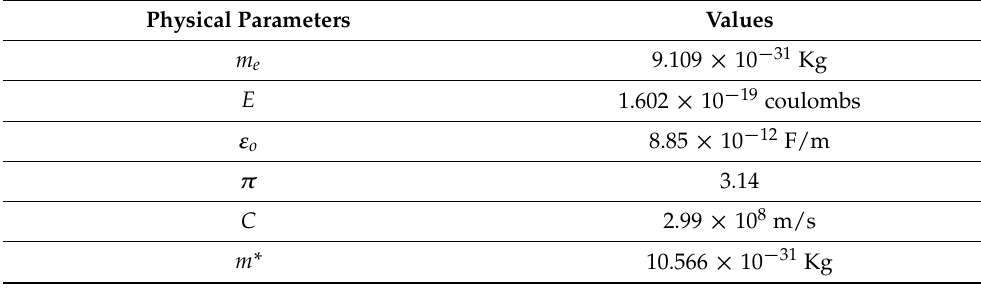
Table 4. Presents the values of N/m* and ԑ ∞ for PVA loadedSn 2+ -complex.